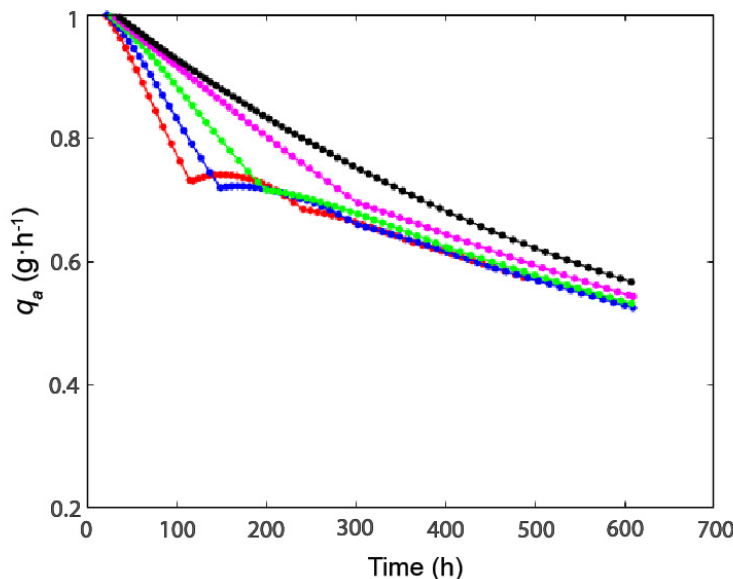
Figure 6. Variation in the accumulated productivity in the one-pot production of lactofructose syrup in sequential batch operation considering one cycle of use of GI and one or more cycles of β -gal use. Simulations were performed considering 40 ◦ C, pH 7, 10% ( w / w ) of initial lactose concentration and GI/ β -gal activity ratio of 0.46 (IU GI /IU β -gal ). Red line: η = 0; blue line: η = 0.2; green line: η = 0.4; purple line: η = 0.6; black line: η = 0.8.